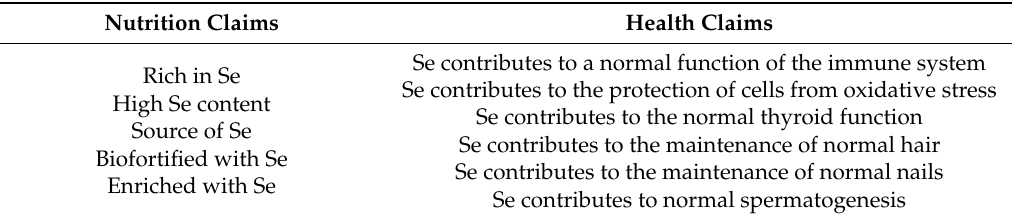
Table 1. Se-related nutrition and health claims the consumers were asked